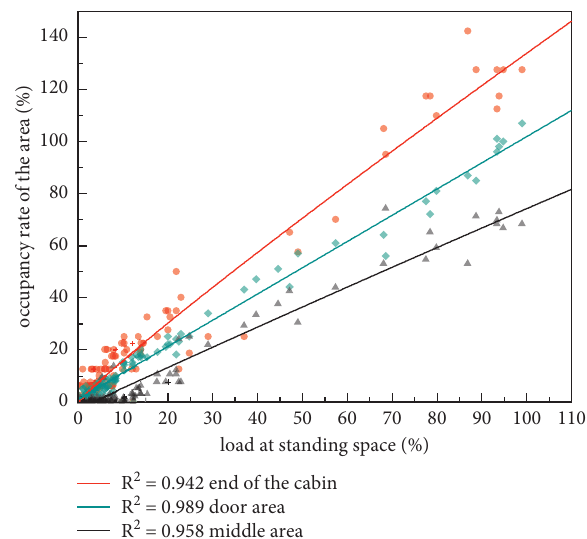
Figure 4: Growth curve of occupancy rates at the ends, door areas, and middle